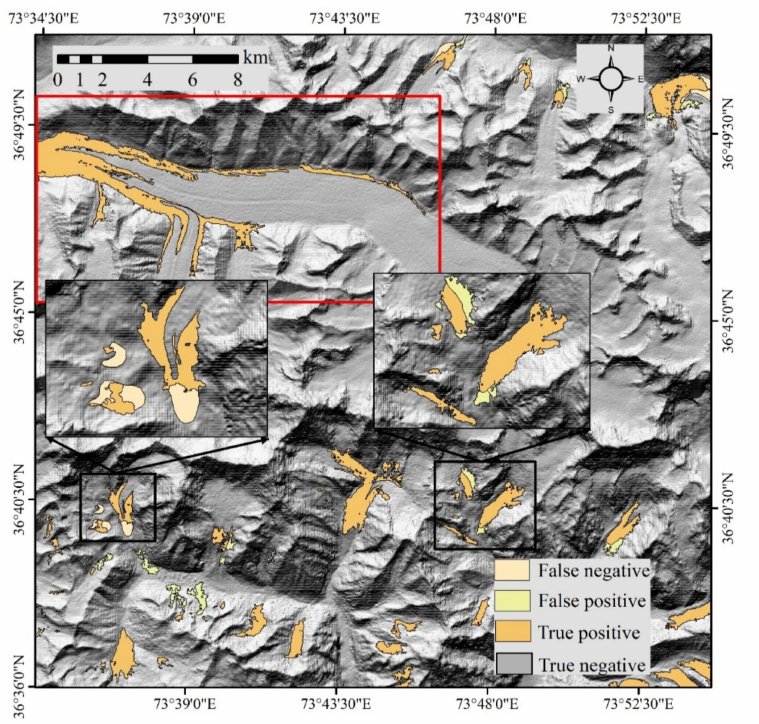
Figure 8. Supraglacial debris mapping at test site 3 (Karakoram) using the proposed algorithm. False-positives and false-negatives are mapped manually using reference data. The red box provides a contextual overview of Figure 10. Table 1. Results of the proposed algorithm on the test sites. Statistical Metric